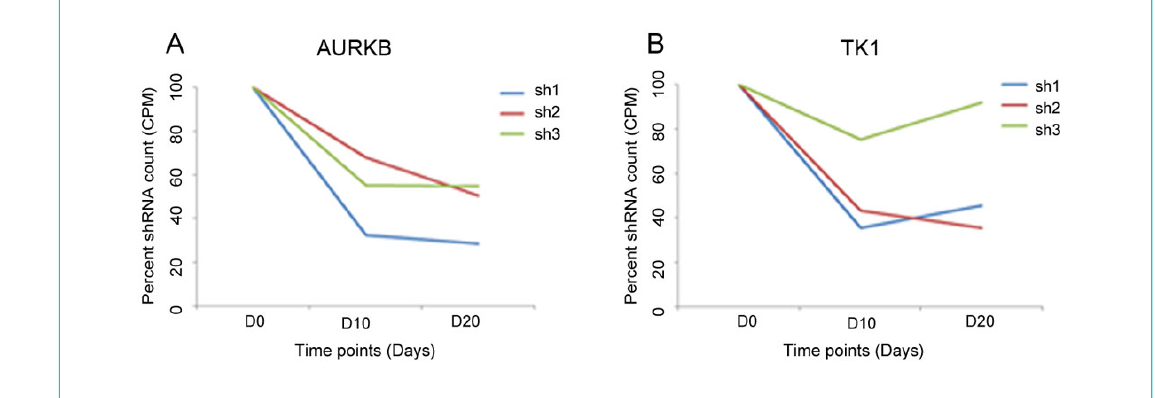
Figure 3: Graph showing percent shRNA counts at day 0, day 10 and day 20 for three shRNAs of AURKB and TK1 . The mean CPM counts of each shRNA construct for both genes across all three screens were obtained and the percent shRNA counts at each time point are